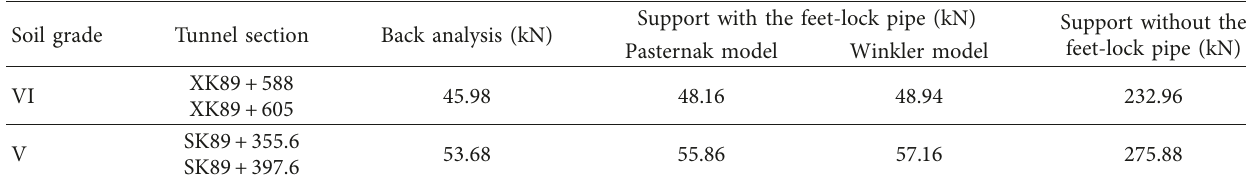
Table 5: Comparison of the predicted vertical loads.